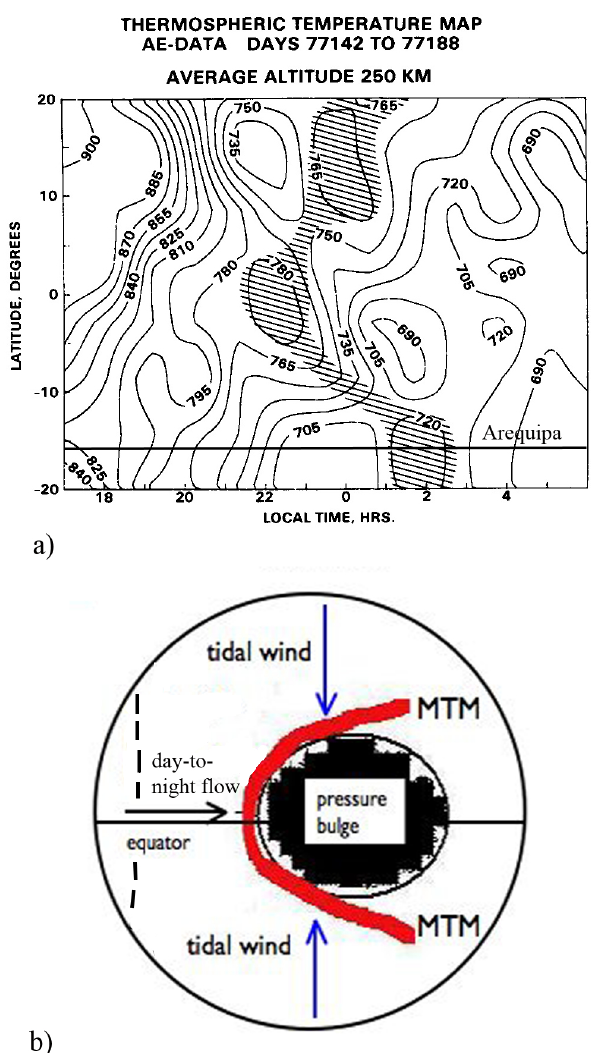
Fig. 12. Comparison of AE temperature data with a conceptual model showing the MTM formation and the spatial distribution of the midnight pressure bulge. (a) AE-E statistical distribution of the MTM determined for the Southern Hemisphere winter (repro- duced from Herrero et al., 1982); (b) conceptual model showing the latitudinal distribution of the MTM formation and spatial distribu- tion plotted against local time. Air moving eastward from the day- side produces converging flow with the thermospheric tidal air flow directed toward the equator from the polar regions in both hemi- spheres. The red region represents the spatial distribution of the MTM formed by compressional heating in the region of the ther- mospheric wind convergence. The dashed vertical line refers to the evening twilight